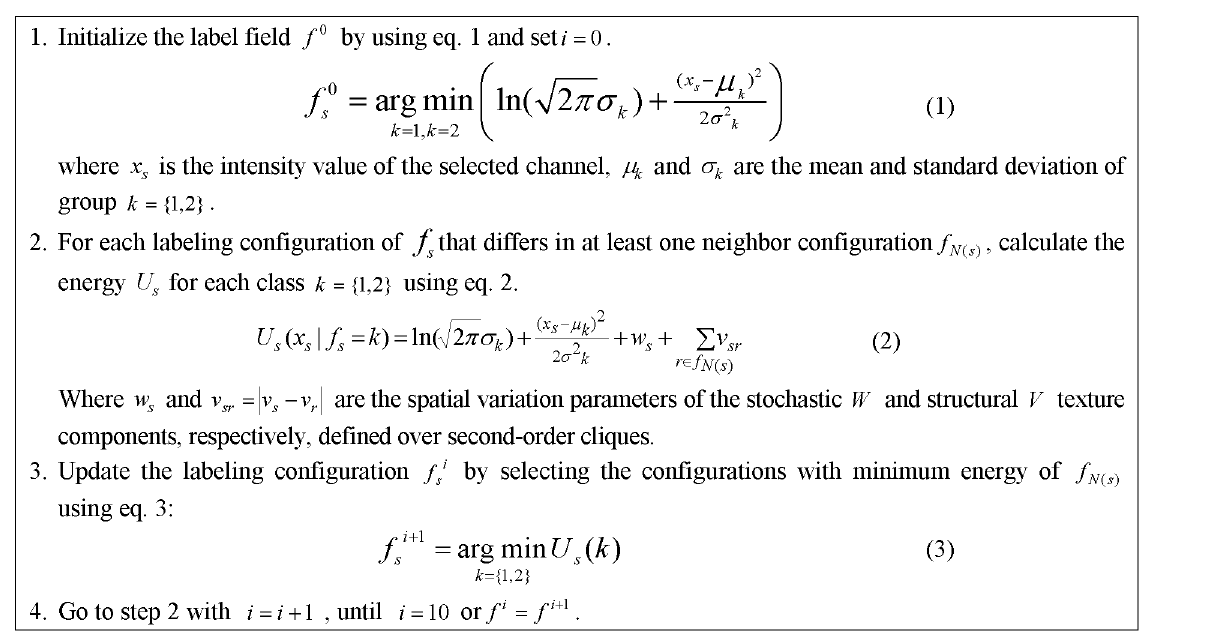
Fig 7. Procedure of MAP estimation for cell segmentation.